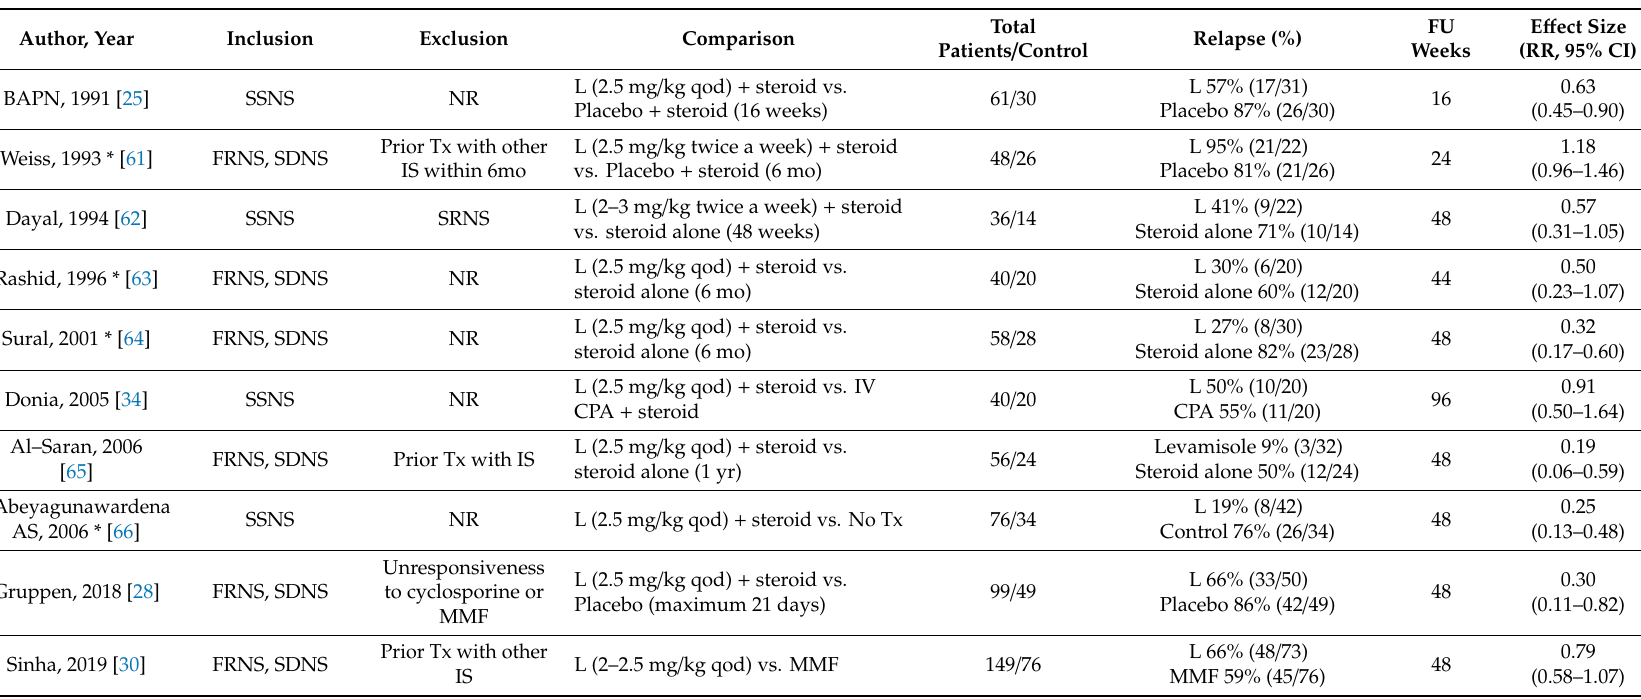
Table 2. Randomized controlled trials of steroid-dependent or frequent relapsing nephrotic syndrome children treated with levamisole